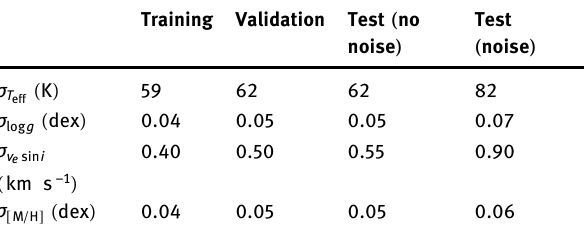
Table 5: Derived standard deviation for each parameter using the TDB for FGK